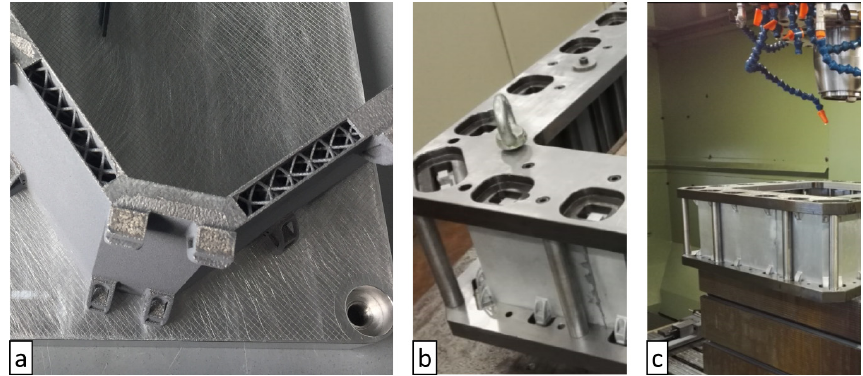
Figure 15. Fabricated component ( a ), assembly within the jig ( b ), machining ( c ).